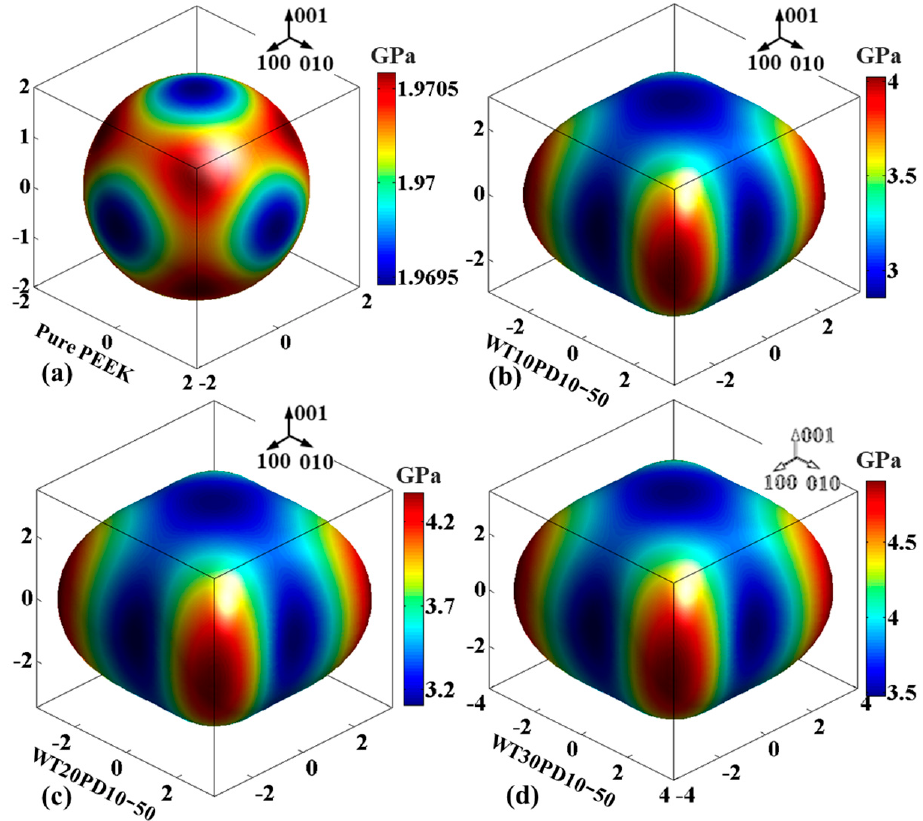
Figure 5. Spatial distribution of elastic modulus for the PEEK material and PEEK/HA composite: ( a ) pure PEEK; ( b ) PEEK/HA (10 wt%) composite; ( c ) PEEK/HA (20 wt%) composite; ( d ) PEEK/HA (30 wt%) composite.